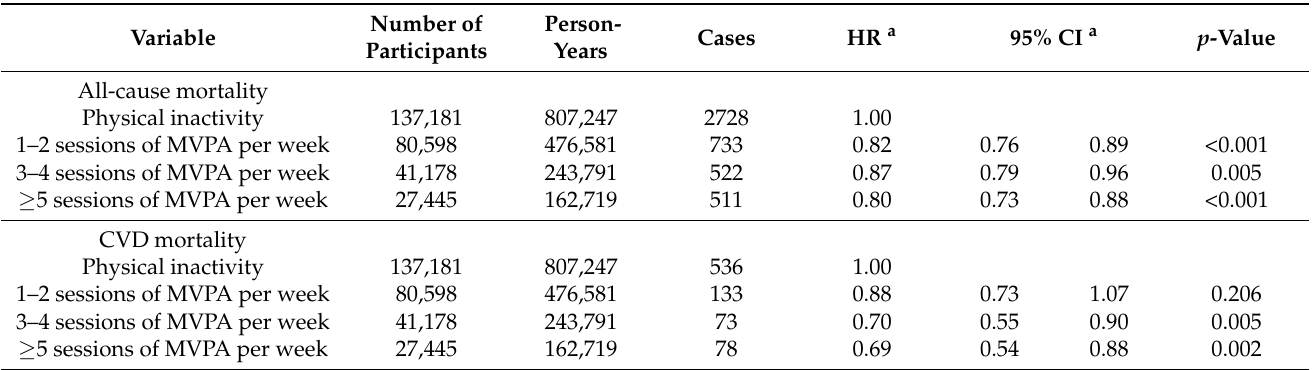
Table 2. Frequency of moderate to vigorous physical activity at baseline period and subsequent risk of all-cause and CVD